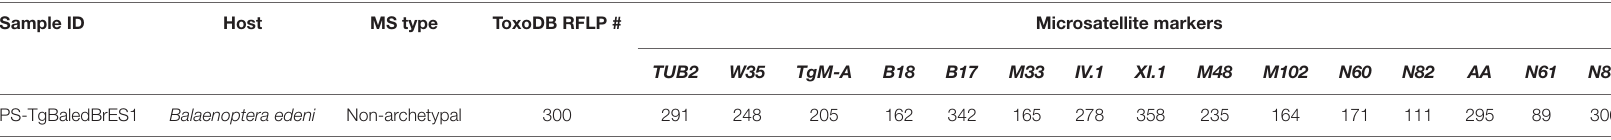
Marker names in bold are the typing